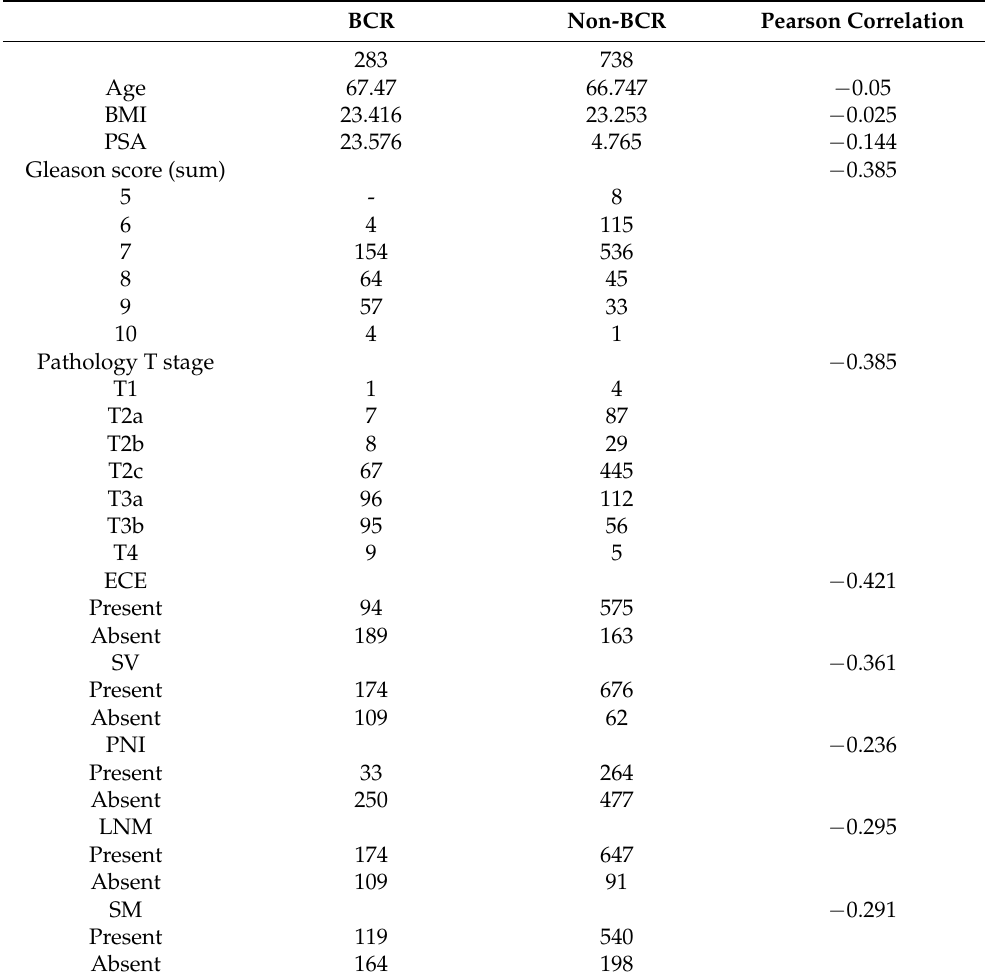
Table 1. Characteristics of patient data. BMI, body mass index; PSA, prostate-specific antigen; ECE, extracapsular extension; SV, seminal vesicle; PNI, perineural invasion; LVM, lymph node metastasis, SM, surgical margin. BCR Non-BCR Pearson